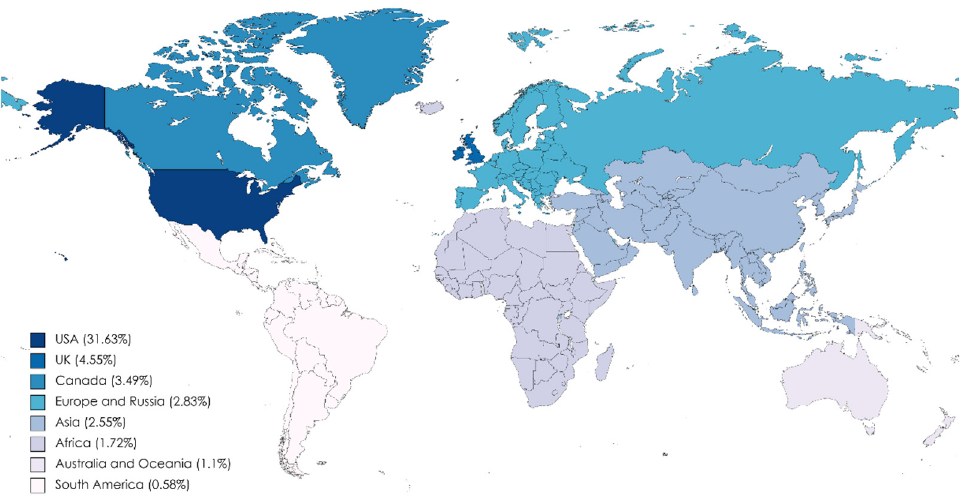
Figure 3. Geographical representation of Twitter activity in period 2 (Source: Own data, created with mapchart.net (accessed on 4 April 2022)).